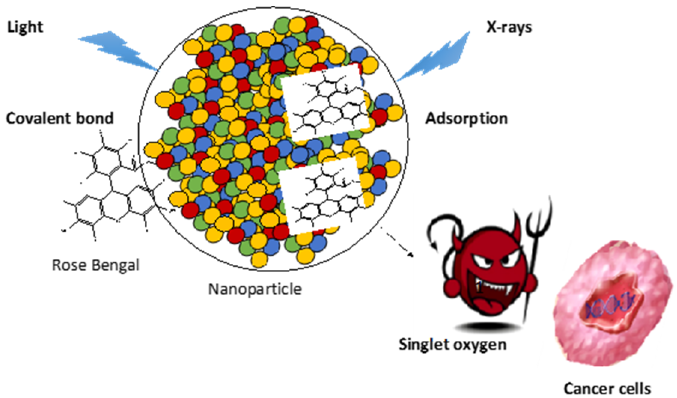
Figure 47. Illustration of nanoparticle coupled to RB for PDT and PDT-X.